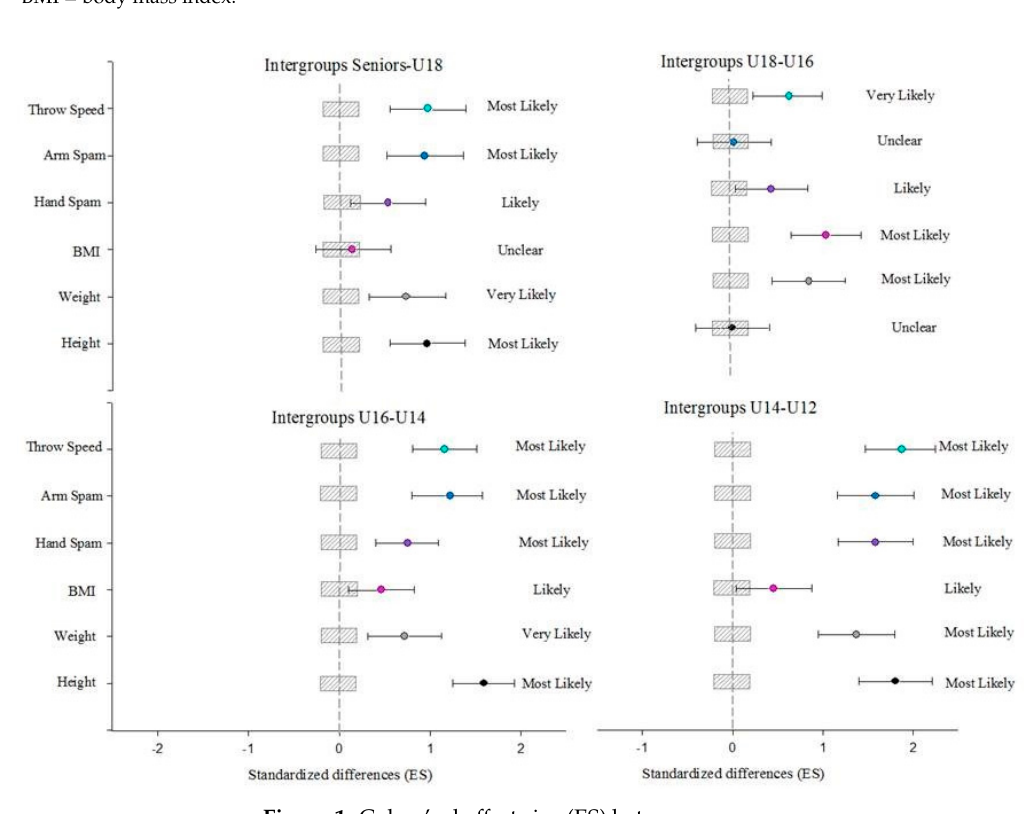
age group; BMI = body mass index.